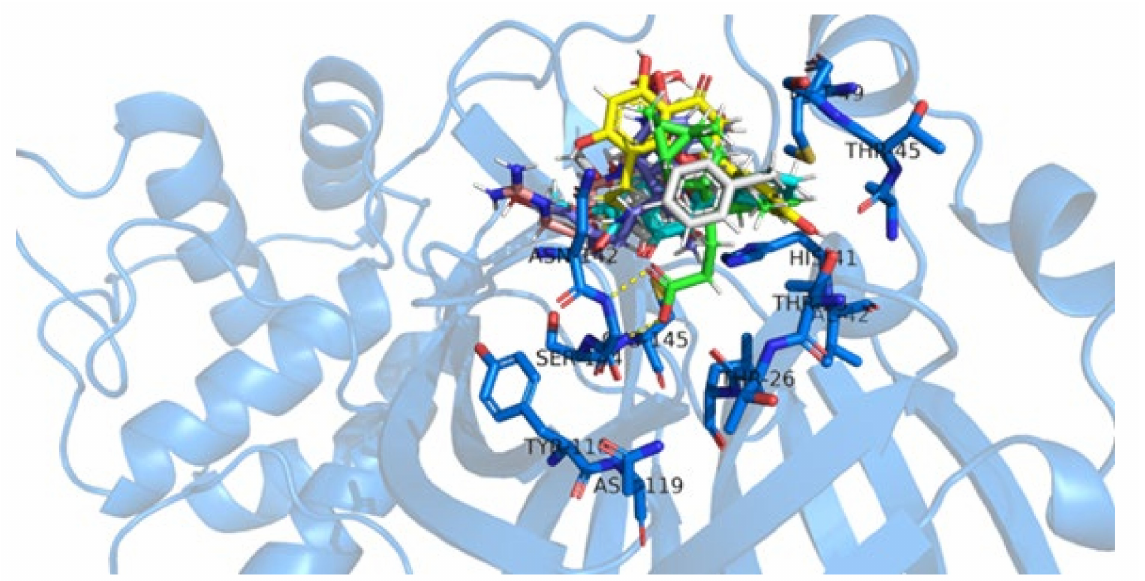
Figure 6. SARS-CoV-2 Mpro main residues that interacted with the best-docked NatProDB compounds throughout the productive phase of the molecular dynamics simulation. Mpro is shown as a cartoon (blue) with its main interacting residues labeled (blue sticks); b01 is shown in green sticks; b02 in cyan; RZS in magenta; and E-64 in orange. Polar interactions are depicted as yellow dashed lines. This image was generated by educational Pymol 2.4.1 [64].